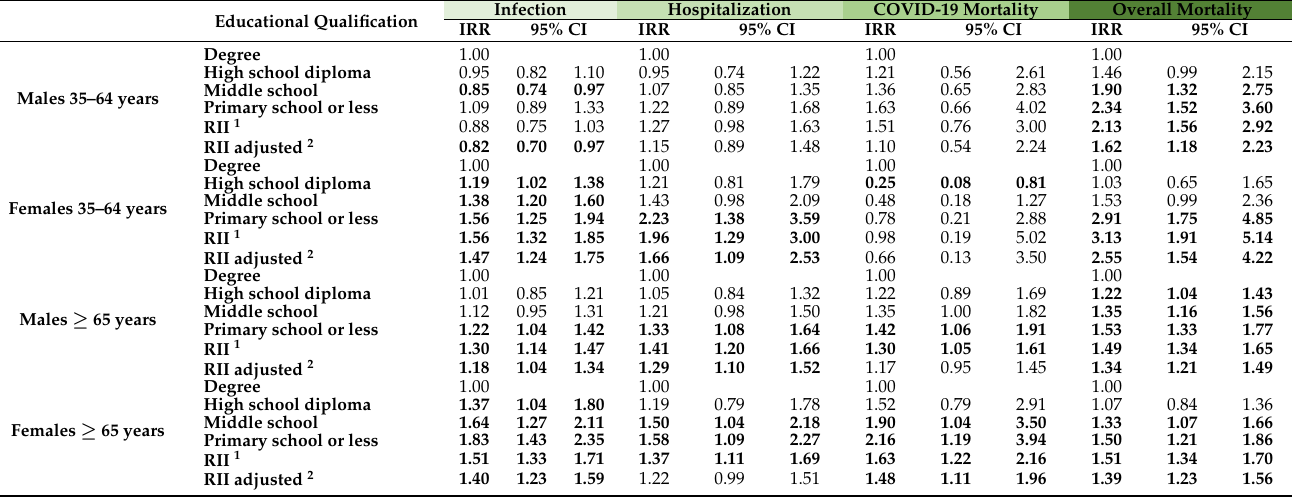
Table A5. SARS-CoV-2 confirmed infection, hospitalization, COVID-19 mortality, and overall mor- tality incidence rate ratios (IRR) and Relative Index of Inequality (RII) by educational qualification, gender, and age